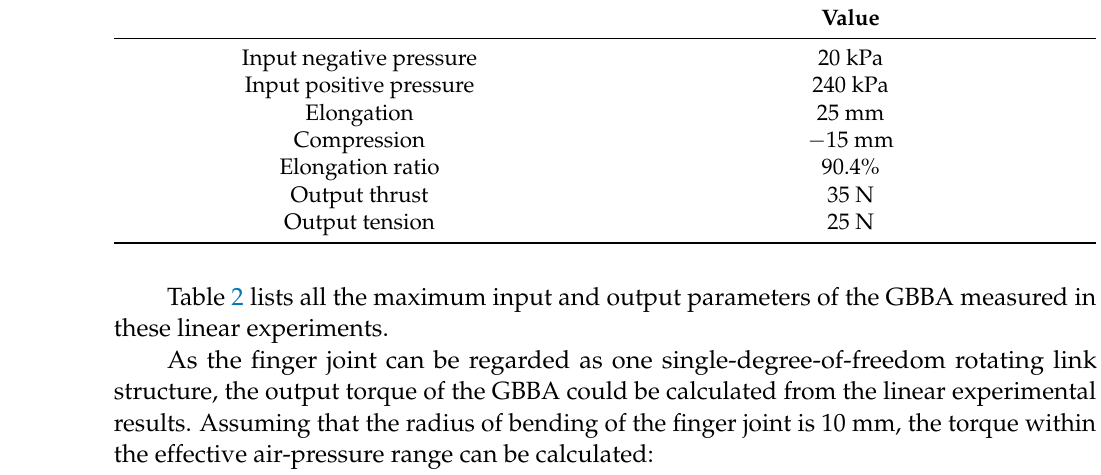
Table 2. Maximum input and output characteristics of the GBBA measured in linear experiments.